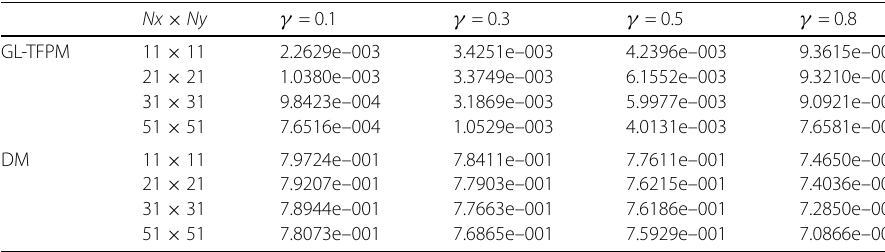
Table 4 The comparison of error between the difference scheme and GL-TFPM Nx × Ny γ = 0.1